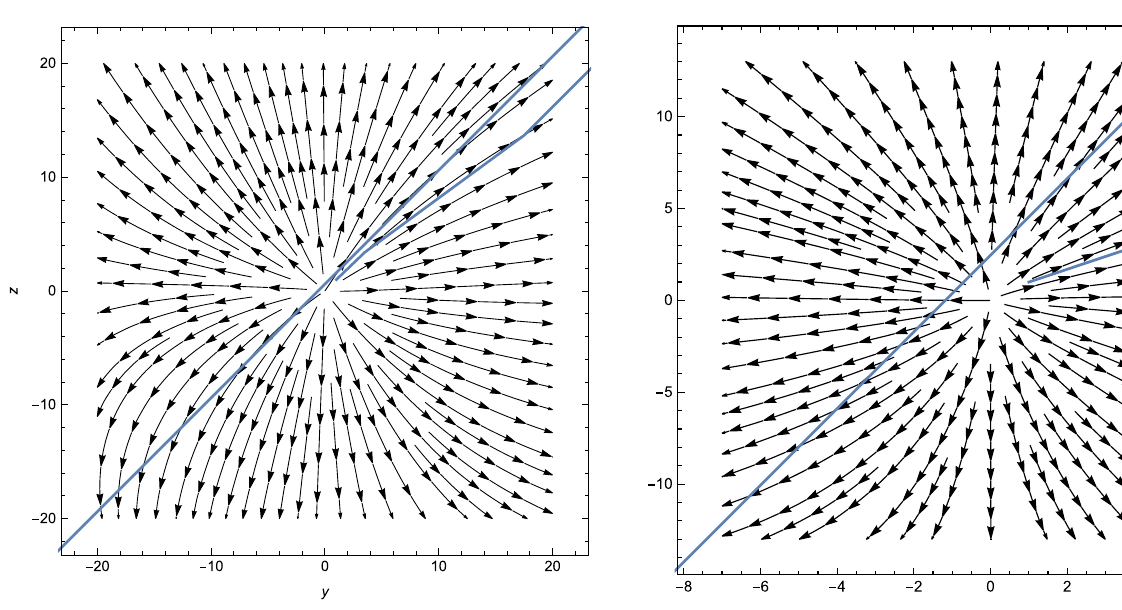
Fig. 12 Thephaseplotofunstablerepeller ( 0 , 0 ) foranalysingstability at infinity for case I when γ = 4 , α 2 > 3 taking C o = 8 π G = 3